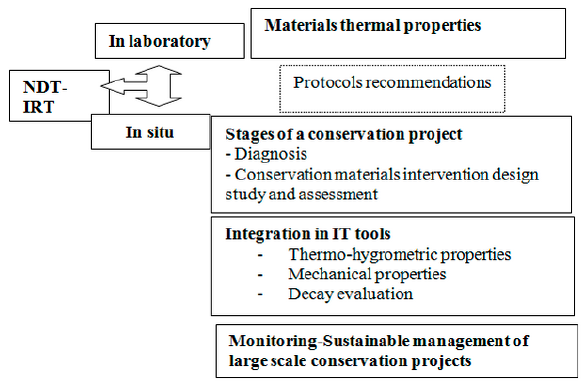
Figure 1. General graph for infrared thermography (IRT) application by National Technical University of Athens.